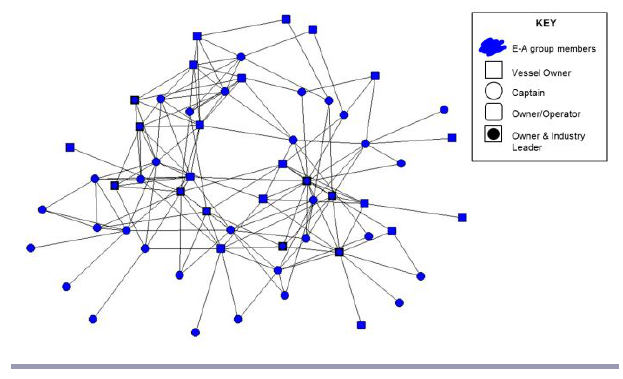
Fig. 4 . Network configuration of ties within the Euro- American (E-A) community. Nodes (representing actors) with the smallest path lengths to each other are placed closest together by an algorithm that uses iterative fitting.